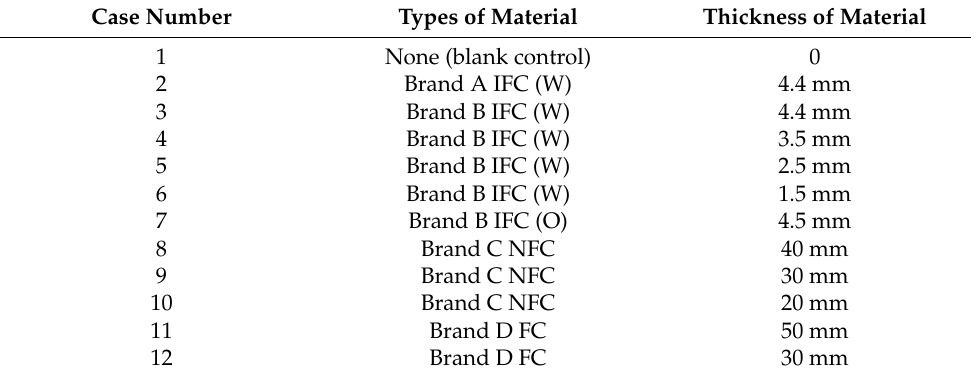
Table 3. Cases of the experiment.